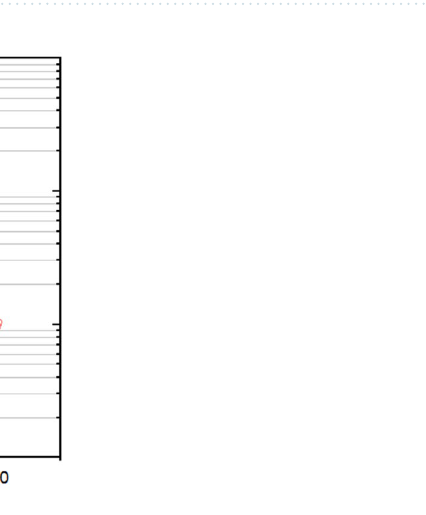
Figure 7. Contour velocity distribution in the horizontal impeller section on the stirred tank for different Reynolds numbers.